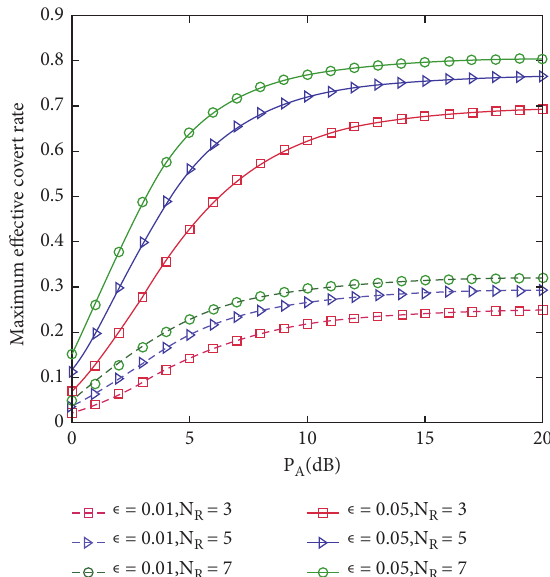
Figure 5: Maximum effective covert rate versus P value of ε and N R , where N R � 5, σ 2 R � 0 dB , R � 1, | h AW | 2 � 1, | h | 2 � 1, and ϕ � 0 . R j W R j with dif-